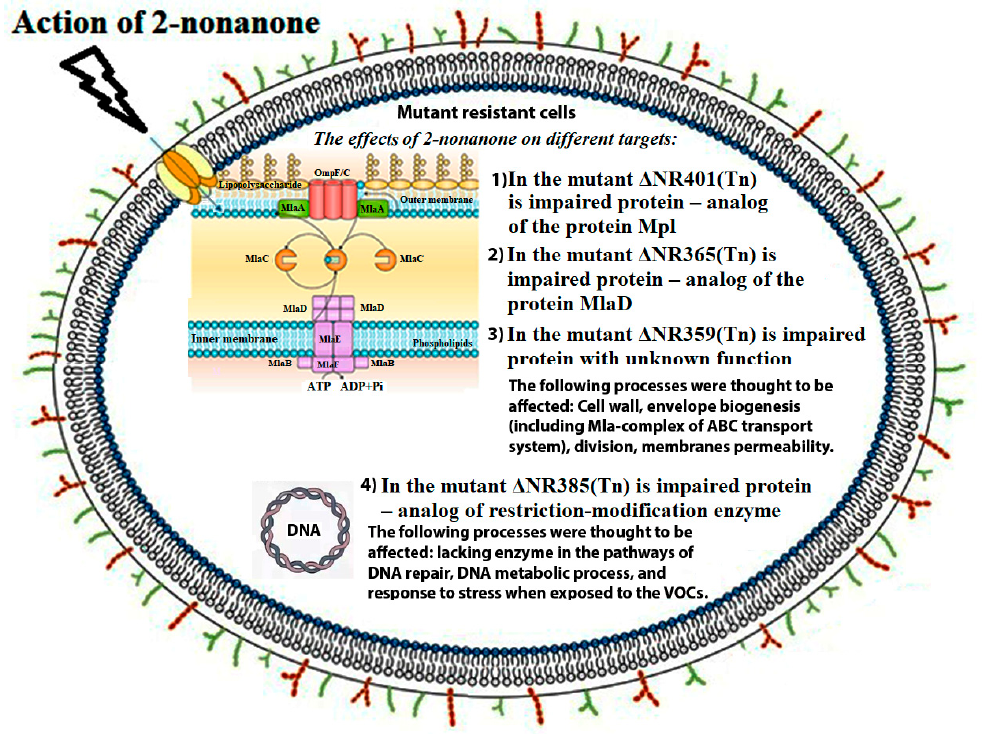
Figure 9. Modes of 2-nonanone action on cyanobacteria cell, (some figure elements are adapted from [47,48]).